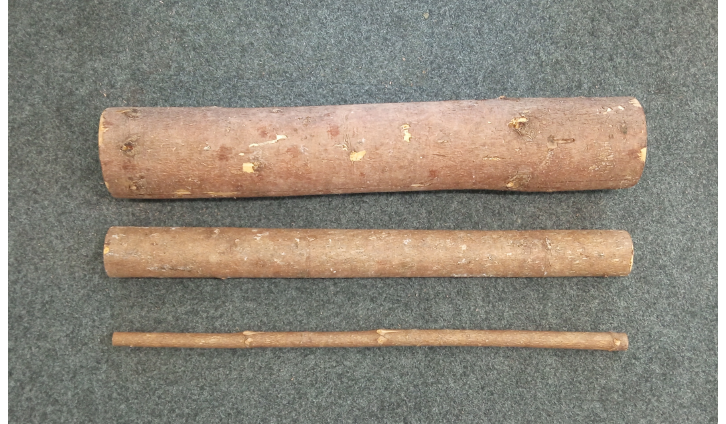
Figure 7. Logs of different diameters used in the grasping experiments. Big log (top) has a diameter of 13.5 cm, medium log (middle) has a diameter of 7.5 cm and small log (bottom) has a diameter of 2.5